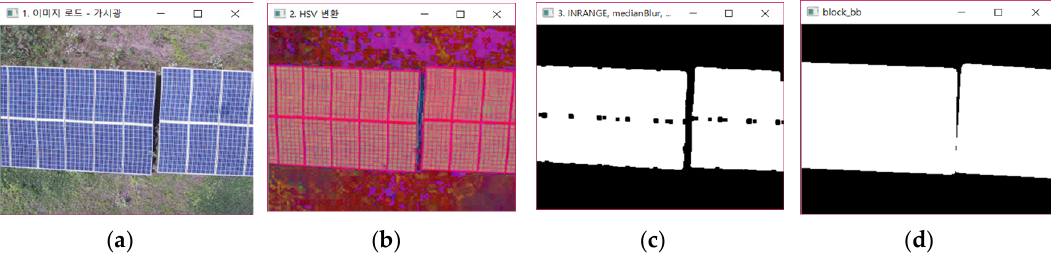
Figure 6. Image processing through HSV image and inrange function: ( a ) visible image; ( b ) HSV image; ( c ) inrange function result; ( d ) mask image (RMImg1).